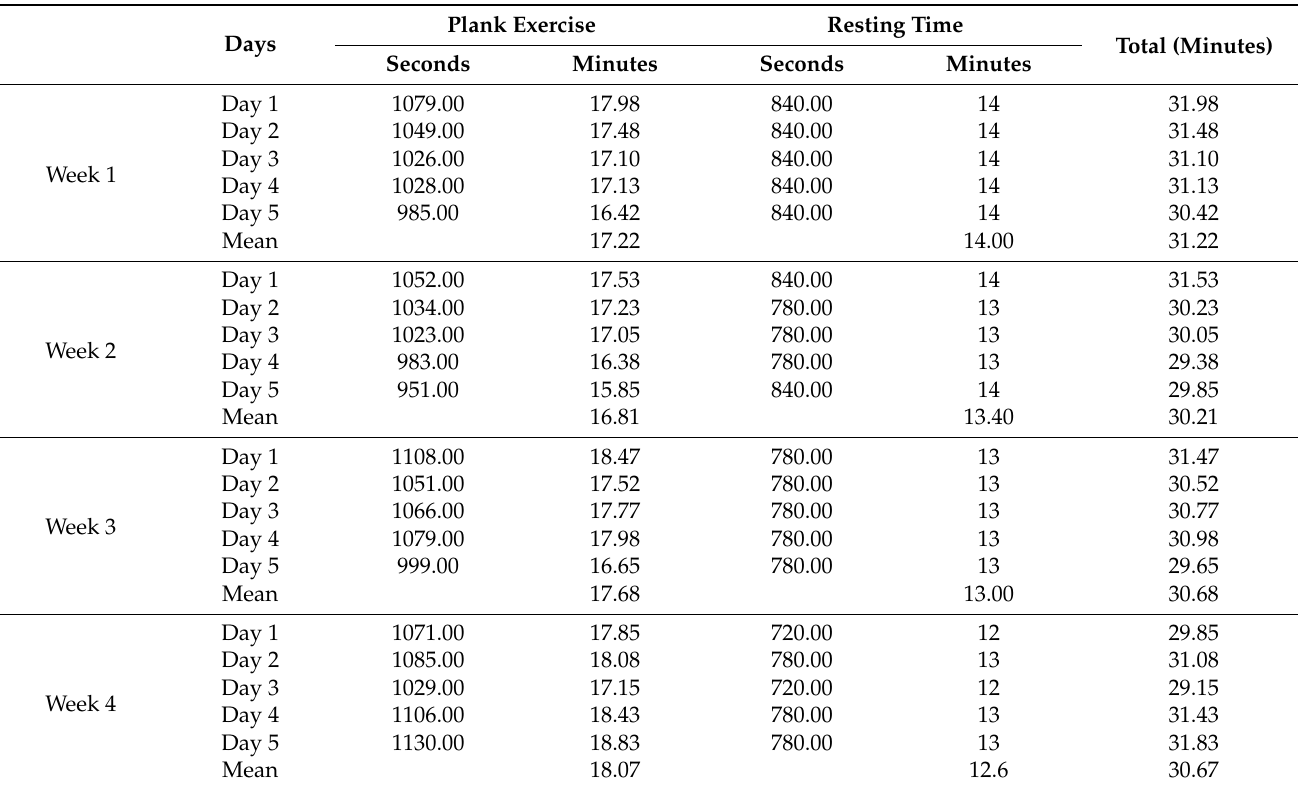
Table 1. Plank exercise time and resting time of the